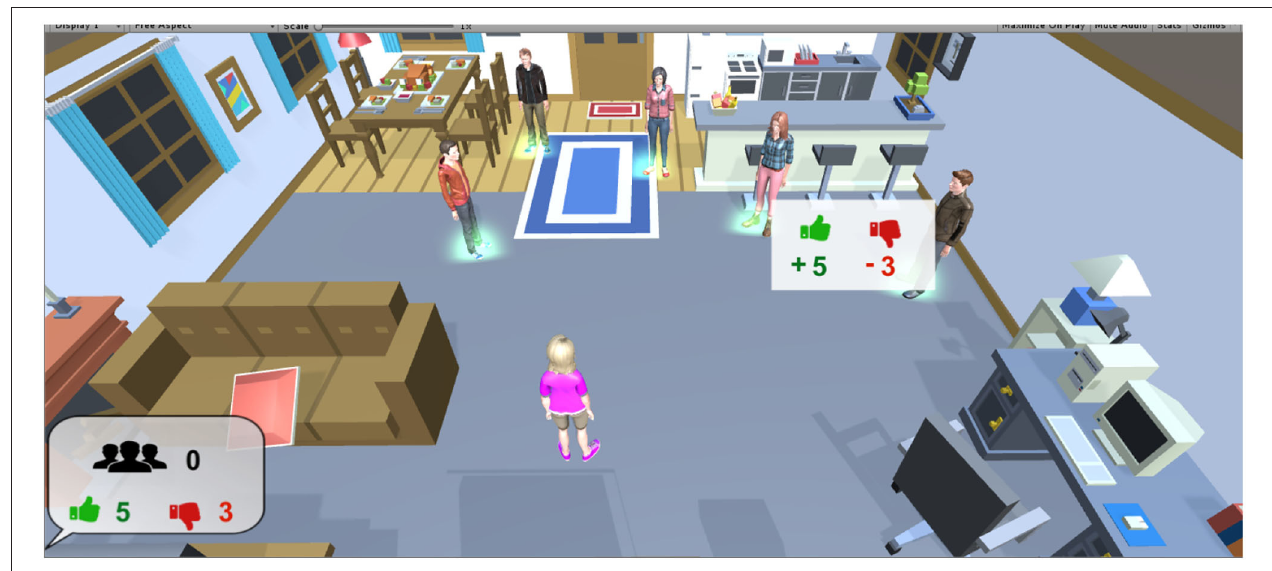
FIGURE 4 | MorALERT serious